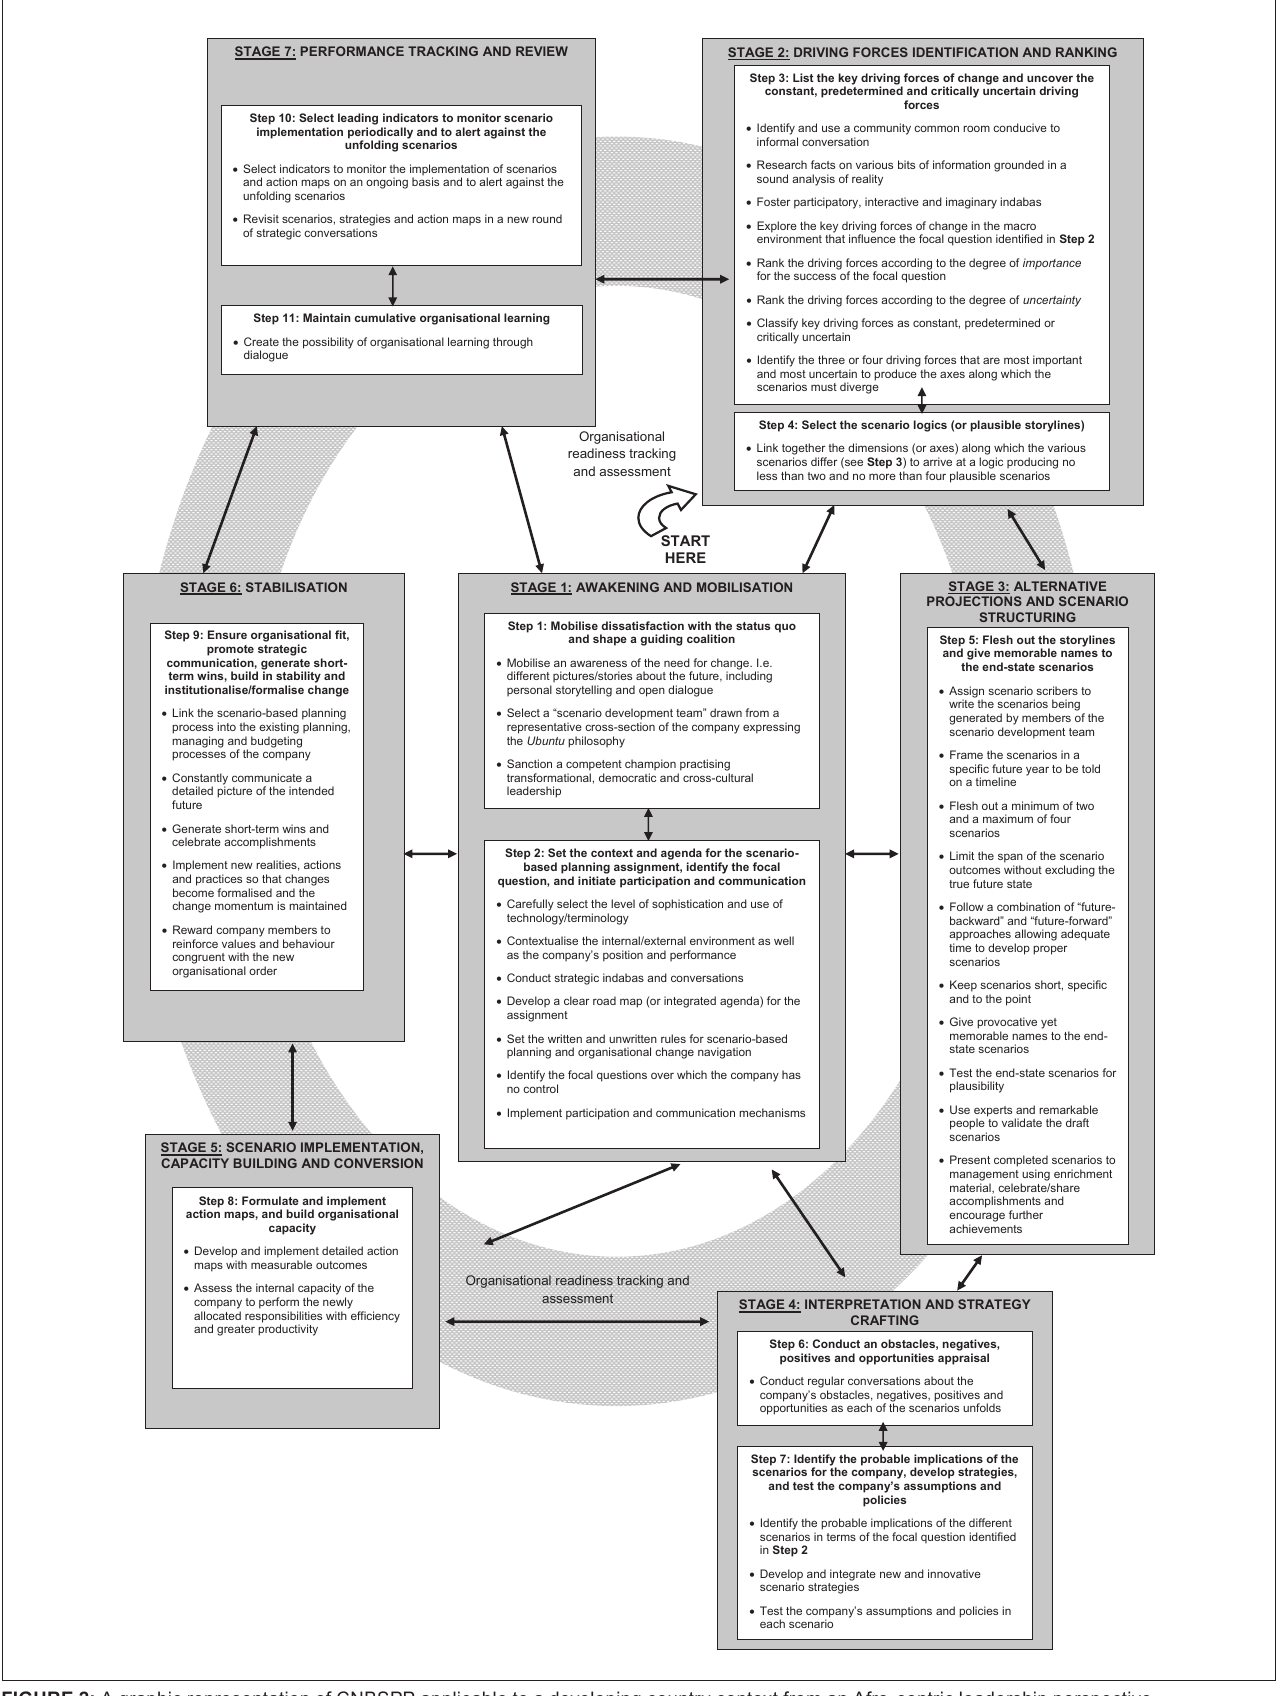
FIGURE 2: A graphic representation of CNBSPP applicable to a developing country context from an Afro-centric leadership